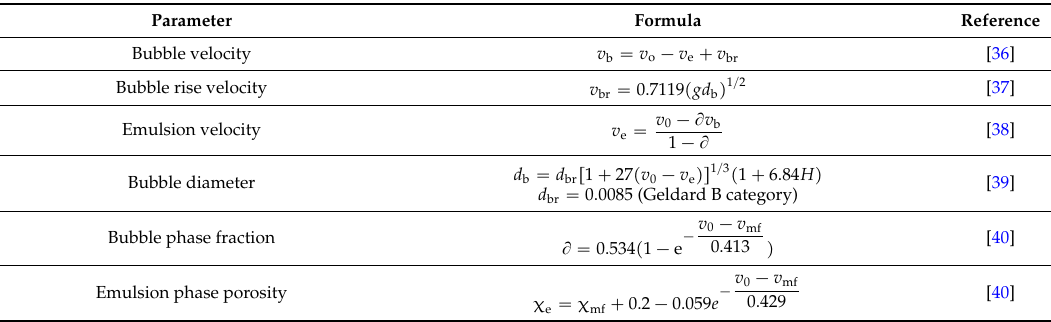
Table 2. Dynamic correlations and formulas applied for the CFD model for the bubble and emulsion